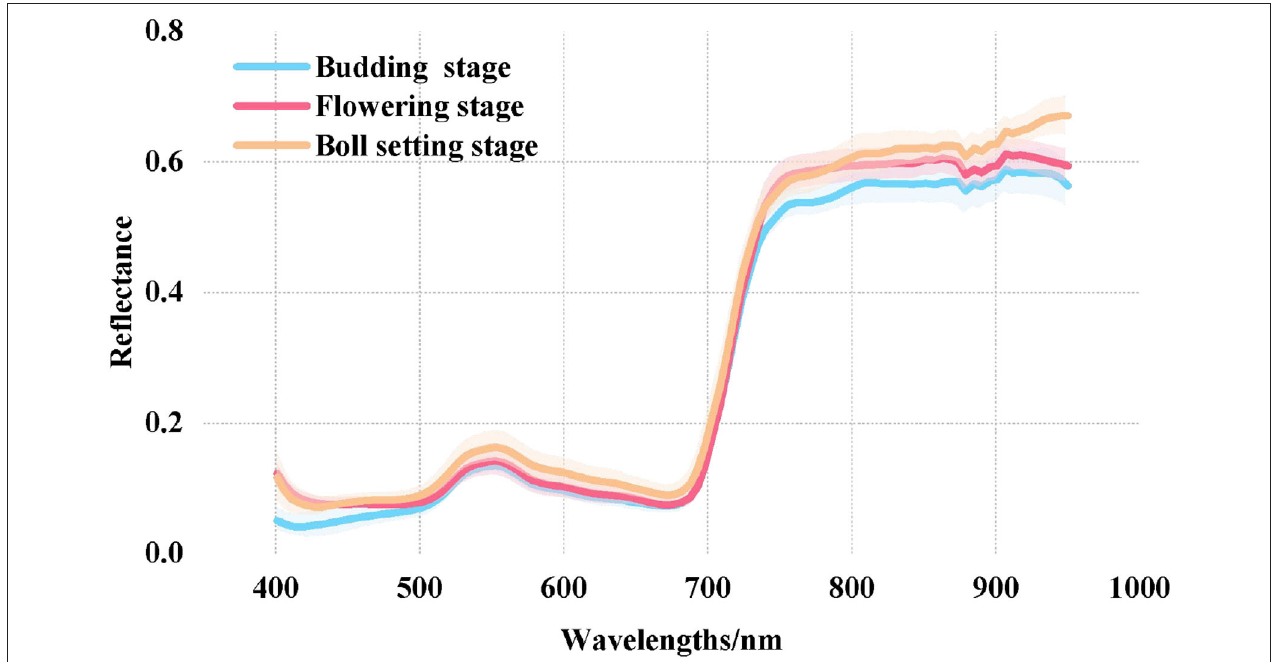
FIGURE 4 | R spectral curves of the LKC in cotton at different growth stages.